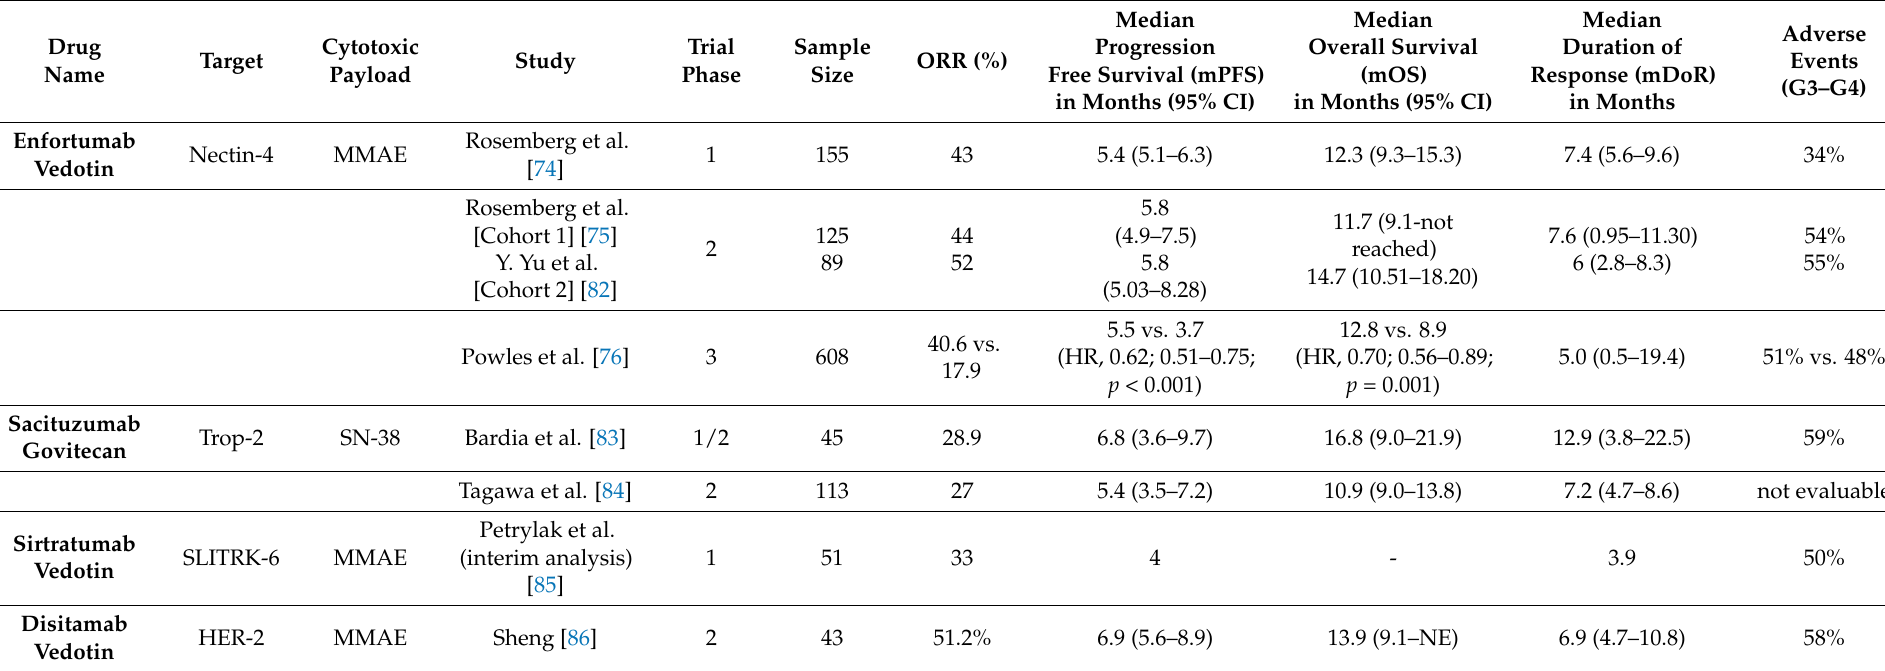
Table 1. Clinical Data on the use of ADCs in Urothelial